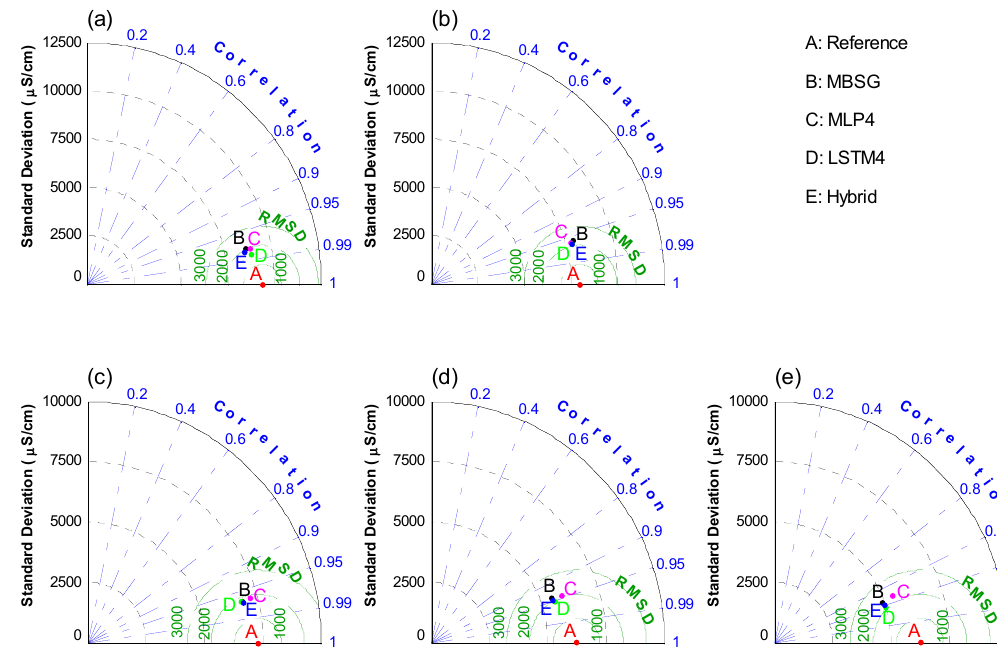
Figure 7. Taylor Diagrams displaying statistics (correlation, standard deviation, and centered root mean square difference) between the reference salinity at Martinez and the corresponding salinity simulations generated via four different models (MLP4, LSTM4, and Hybrid MBSG – CNN) grouped in five water year types including ( a ) wet year, ( b ) above-normal year, ( c ) below-normal year, ( d ) dry year, and ( e ) critical year.